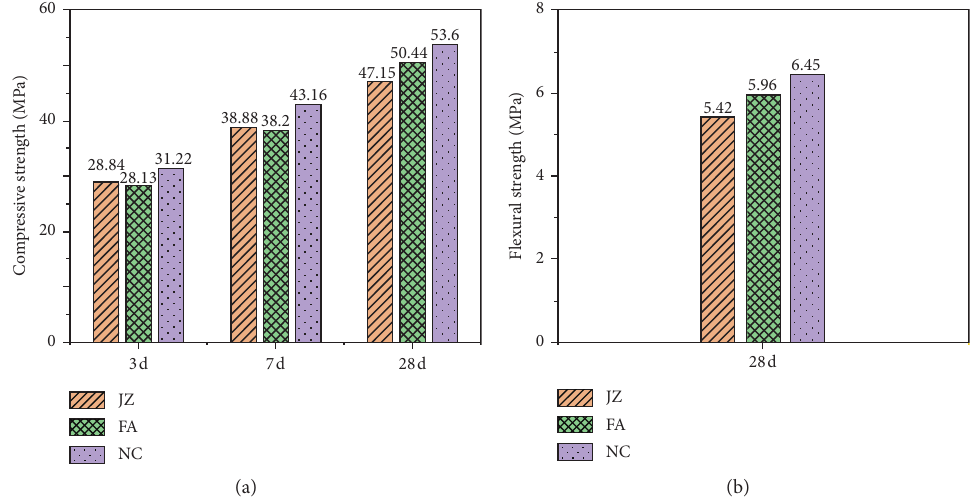
Figure 3: Mechanical properties of different concretes: (a) compressive strength at 3, 7, and 28d; (b) flexural strength at